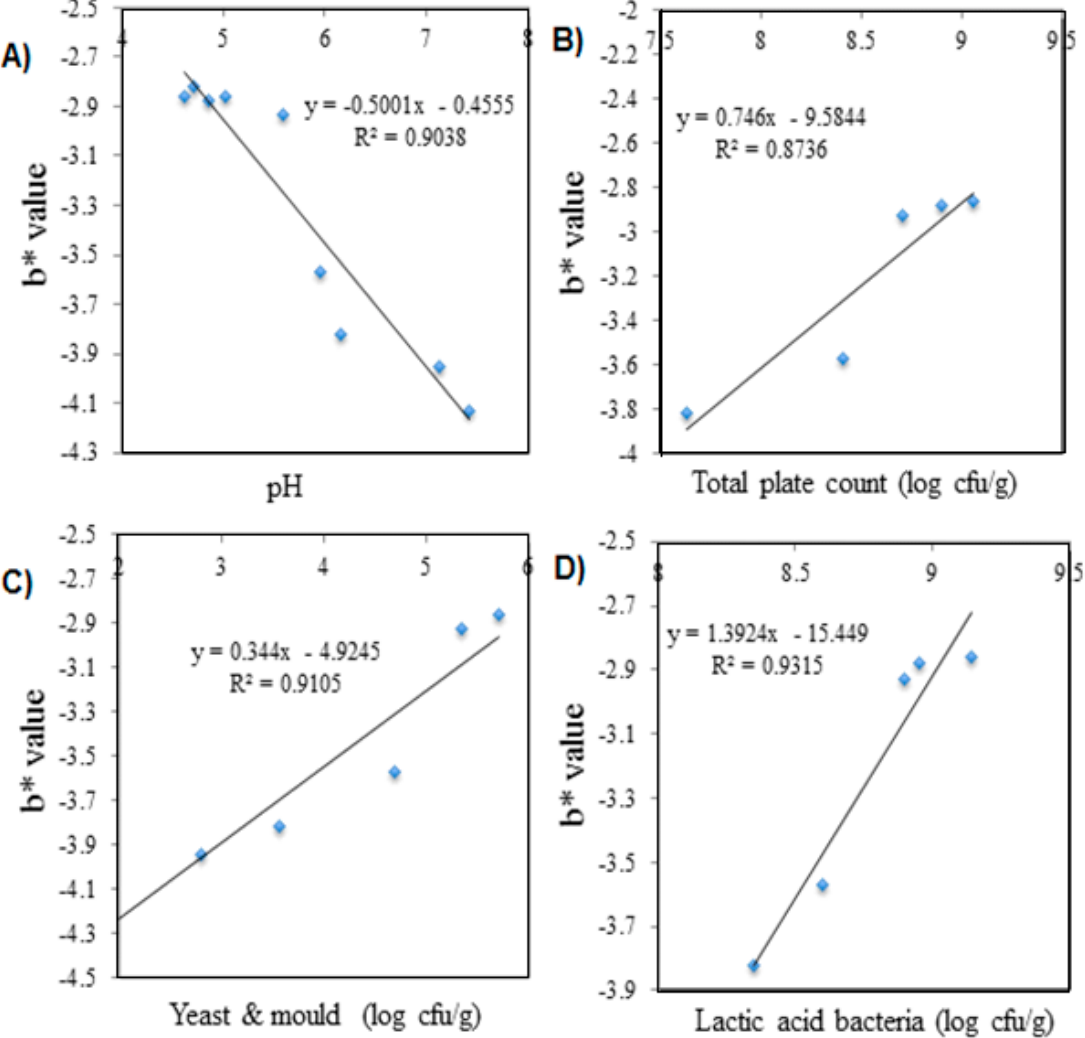
Figure 7. Correlation between b* value of colorimetric pH sensor film and parameter analysis of durian samples—( A ) pH value; ( B ) Total plate count—( C ) Yeast & mold counts; ( D ) Lactic acid bacteria counts (LAB).